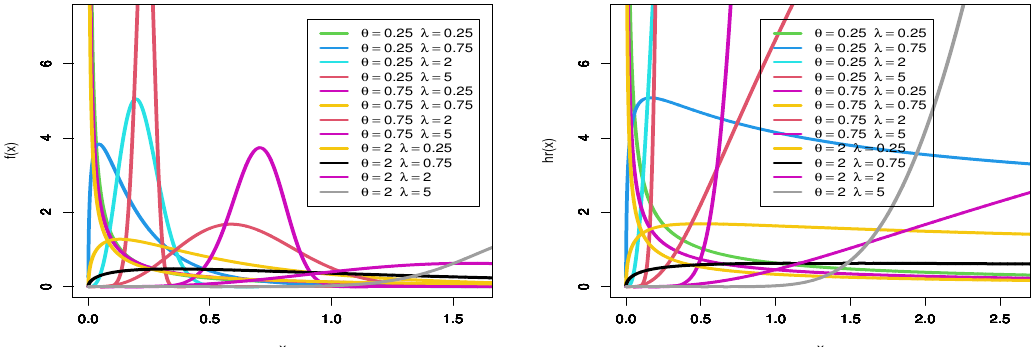
Figure 1. Pdfs and hrfs of the GB( θ , λ ) distribution for selected values of θ and λ . Step 2 : The MLEs of the unknown parameters θ and λ are obtained under the SRS and RSS schemes for each n and specified parameter